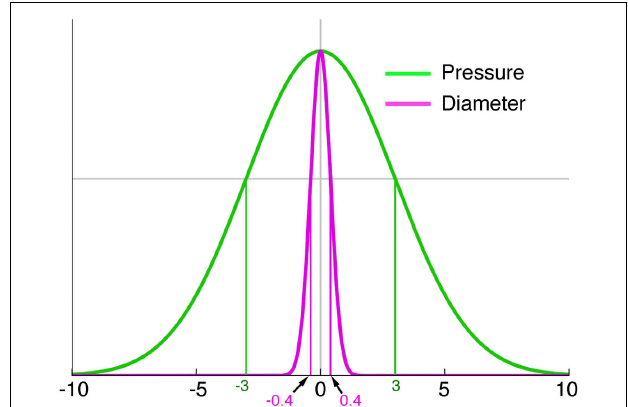
FIGURE 4 | A model of the probability of a mechanical state being regarded as quiescent. The green line represents pressure and the magenta represents diameter. The x axis indicates the diameter (mm/s) or pressure (mmHg/s) time derivatives. The y axis represents conditional probability of quiescence at a given diameter or pressure time derivative. A value of 0 for either pressure or diameter indicates a strong probability of a quiescent state. A Hidden Markov Model was used to determine when a state moved from quiescence to activity (Wiklendt et al., 2013). Normalizing the pressure and diameter data was achieved by dividing each value by a constant defining the width of the quiescence model conditional probability curve (shown at vertical green and magenta lines). The constant for pressure was 3mmHg/s and the constant for diameter was